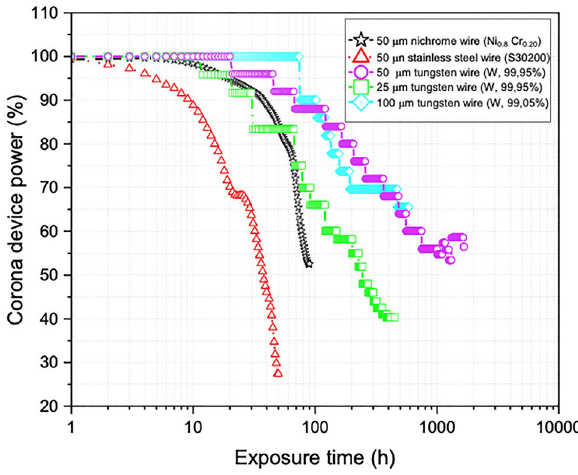
Figure 2. Power loss of different electrode wires under positive high voltage corona discharge.